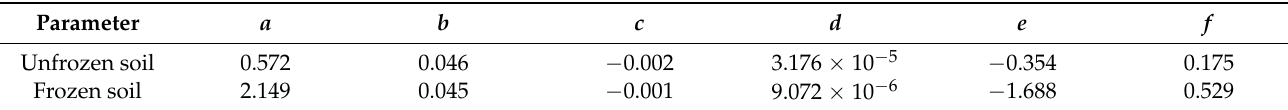
Table 4. Related parameters of thermal diffusivity binary fitting.